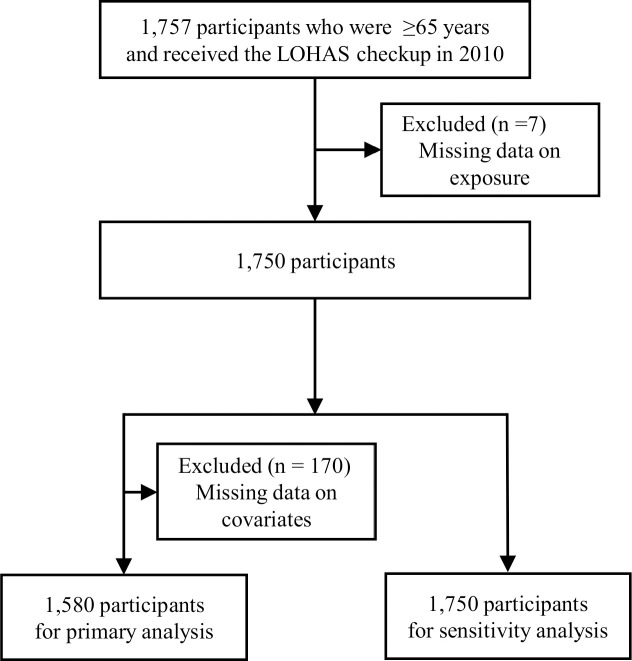
Participant flow.